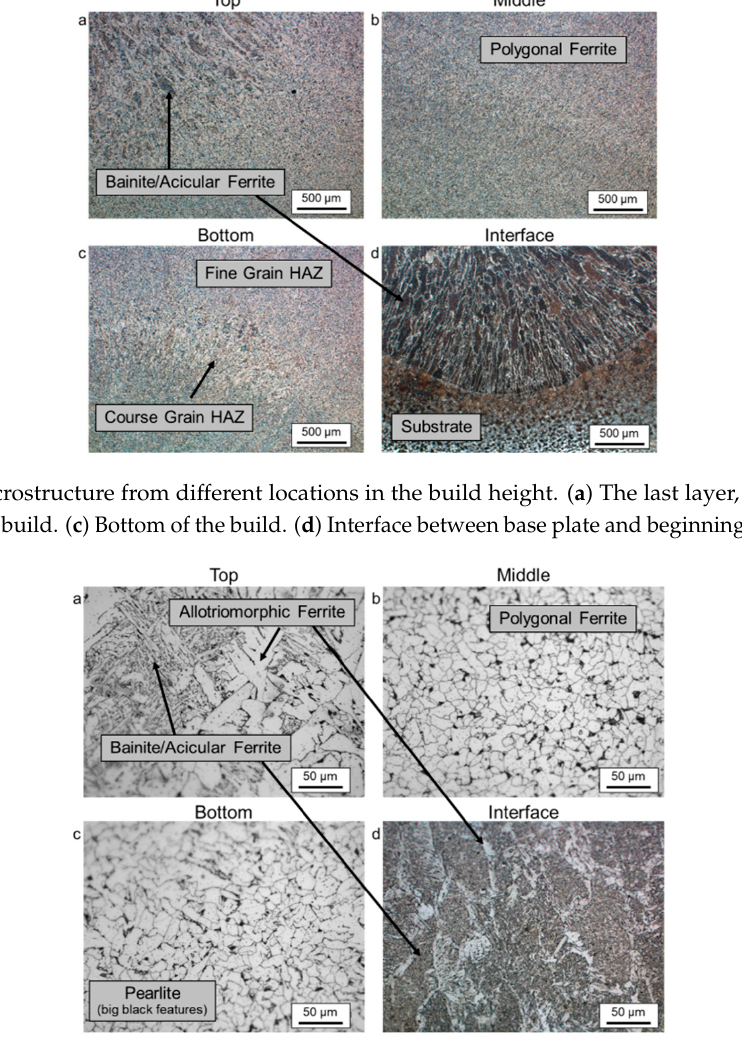
Figure 10. High magnification micrographs from different locations in the build height. ( a ) The last layer, top. ( b ) The middle of the build. ( c ) Bottom of the build. ( d ) Interface region between base plate and beginning of the build.